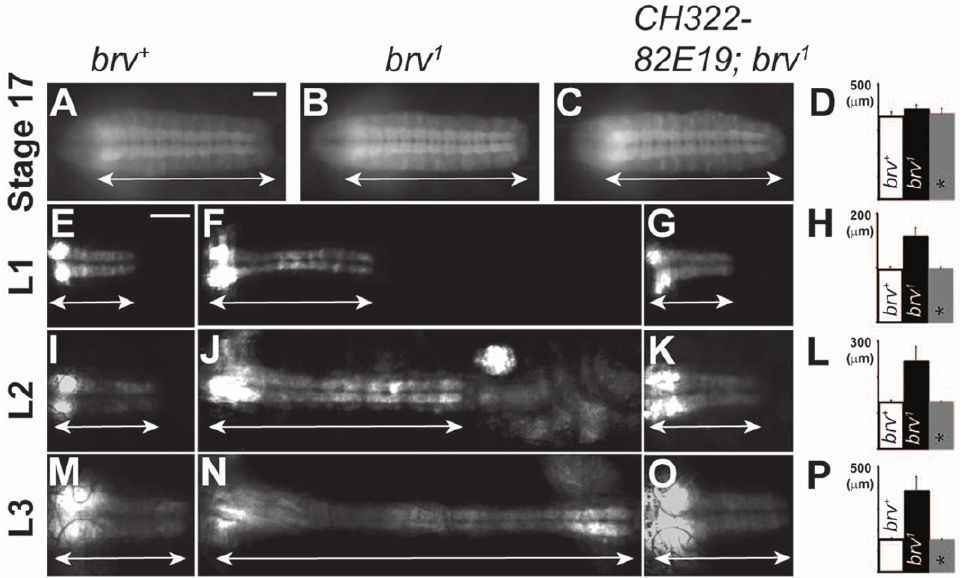
Figure 3. The VNC in brv mutants elongates during larval development and can be rescued by ectopic GlcAT-P expression. An Elav- mCD8-GFP background is used to visualize the outlines of the VNC. (A–C) Representative images of stage 17 embryos. (A) Wild-type ( brv + ) and (B) brv 1 maternal and zygotic mutant. The progressive elongation of the VNC during larval development is shown in L1 (E–G), L2 (I–K) and L3 (M–O). Larval brains from wild-type (E, I, M), brv 1 (F, J, N) and specimen over-expressing GlcAT-P (C, G, K, O) in brv 1 mutant background are shown. (D, H, L, P) Quantification of the length of the VNC (n=7, for each stage) is presented (* refers to CH322-82E19 rescued specimen. Double-sided arrows indicate the length of the VNC. L1, 2, 3 refers to larval stages 1, 2, and 3. Bars: 50 m m.